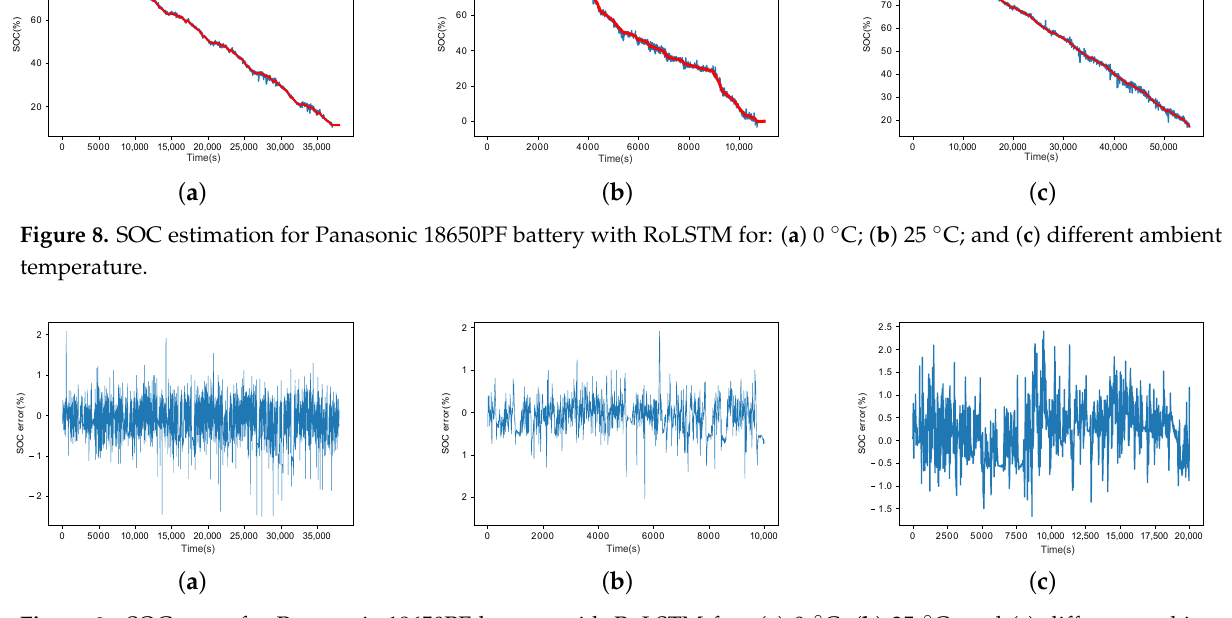
Figure 9. SOC error for Panasonic 18650PF battery with RoLSTM for: ( a ) 0 ◦ C; ( b ) 25 ◦ C; and ( c ) different ambient temperature. Table 3 details the MAE, RMSE and MAX error metrics, at 0, 10, and 25 ◦ C for